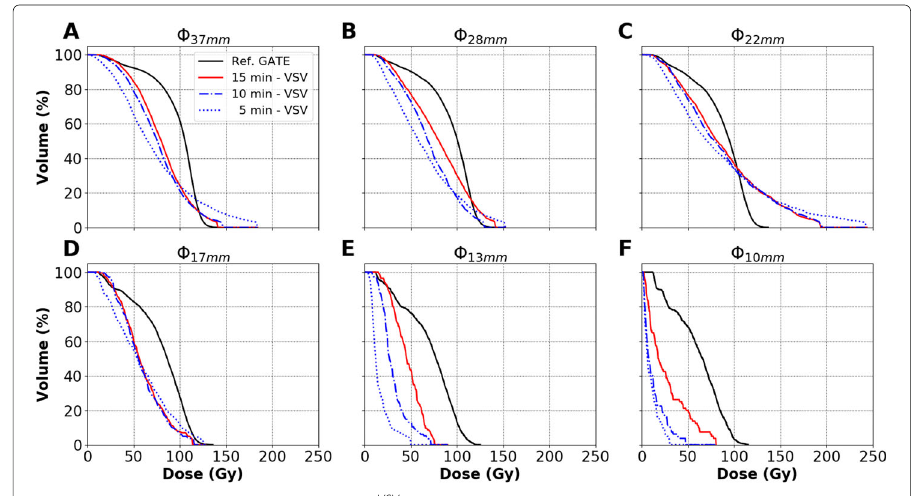
Fig. 5 Effect of acquisition duration on DVH VSV pet for all spheres. A 37 mm, B 28 mm, C 22 mm, D 17 mm, E 13 mm and F 10 mm. Reconstructions were performed using i3s10-2mm. The x-axis and y-axis in each figure have the same corresponding limits